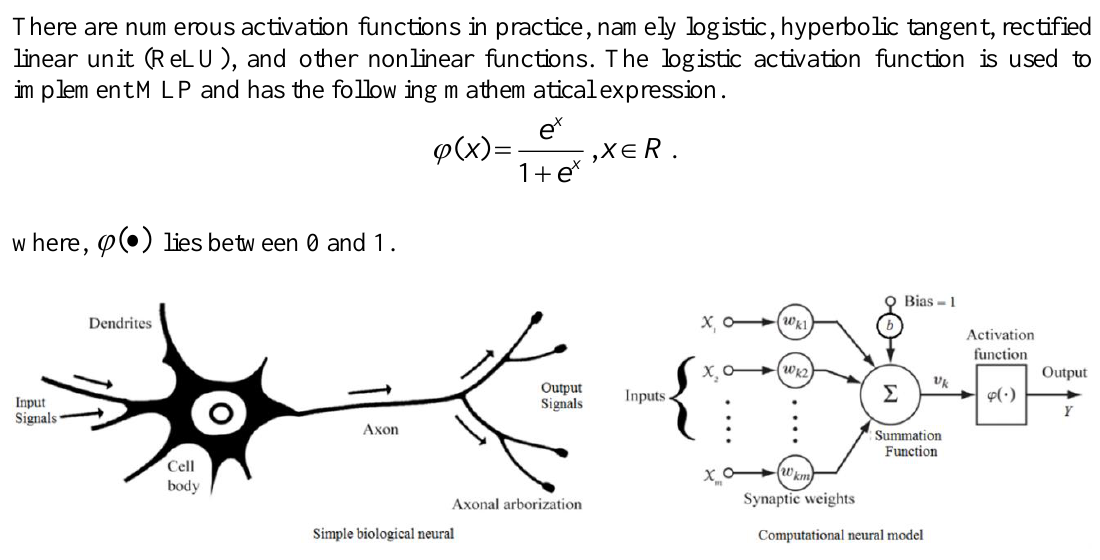
Figure 2. Simple biological neural versus computational neural